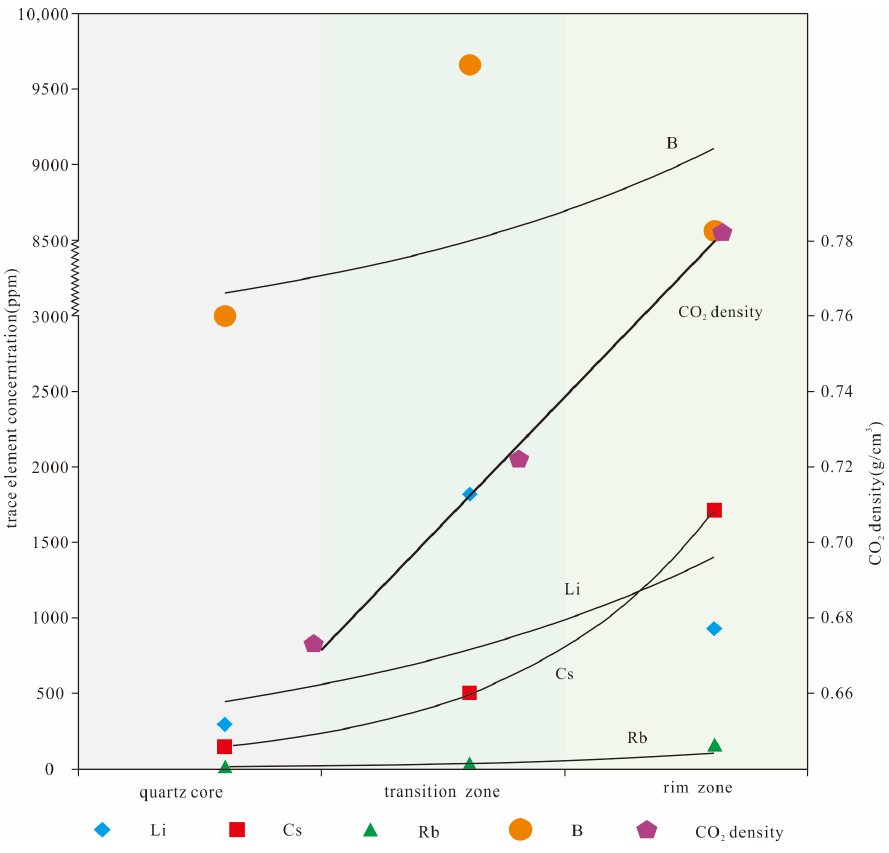
Figure 11. Covariance diagram of rare metal elements and CO 2 content in each textural zone.